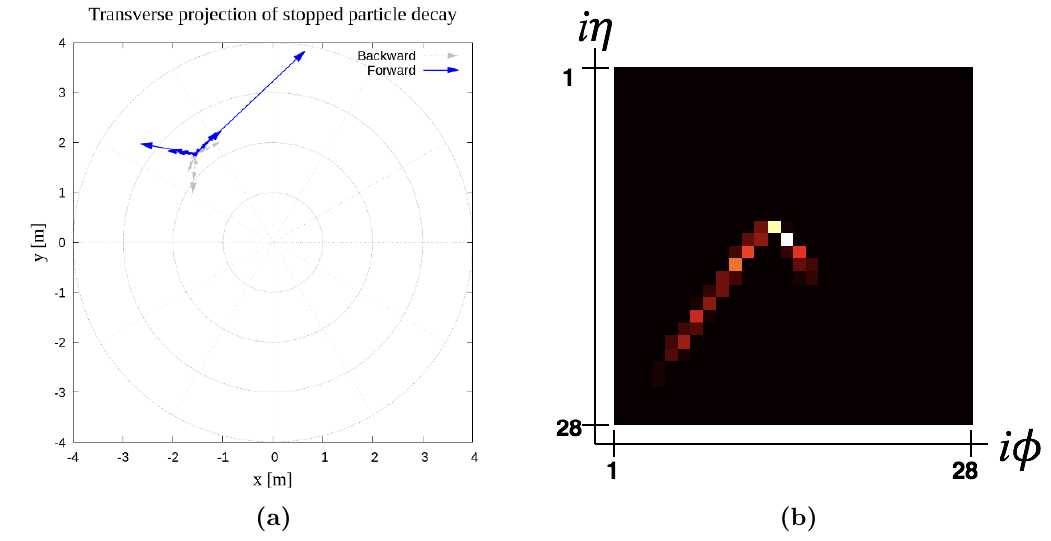
Figure 13. (a) Stopped particle decay projection in the transverse plane | shown in grey and blue are particles moving backward and forward respectively; (b) Energy deposition of forward-moving particles coming from the decay of a stopped particle in the HCAL. Both images are for the same stopped particle decay